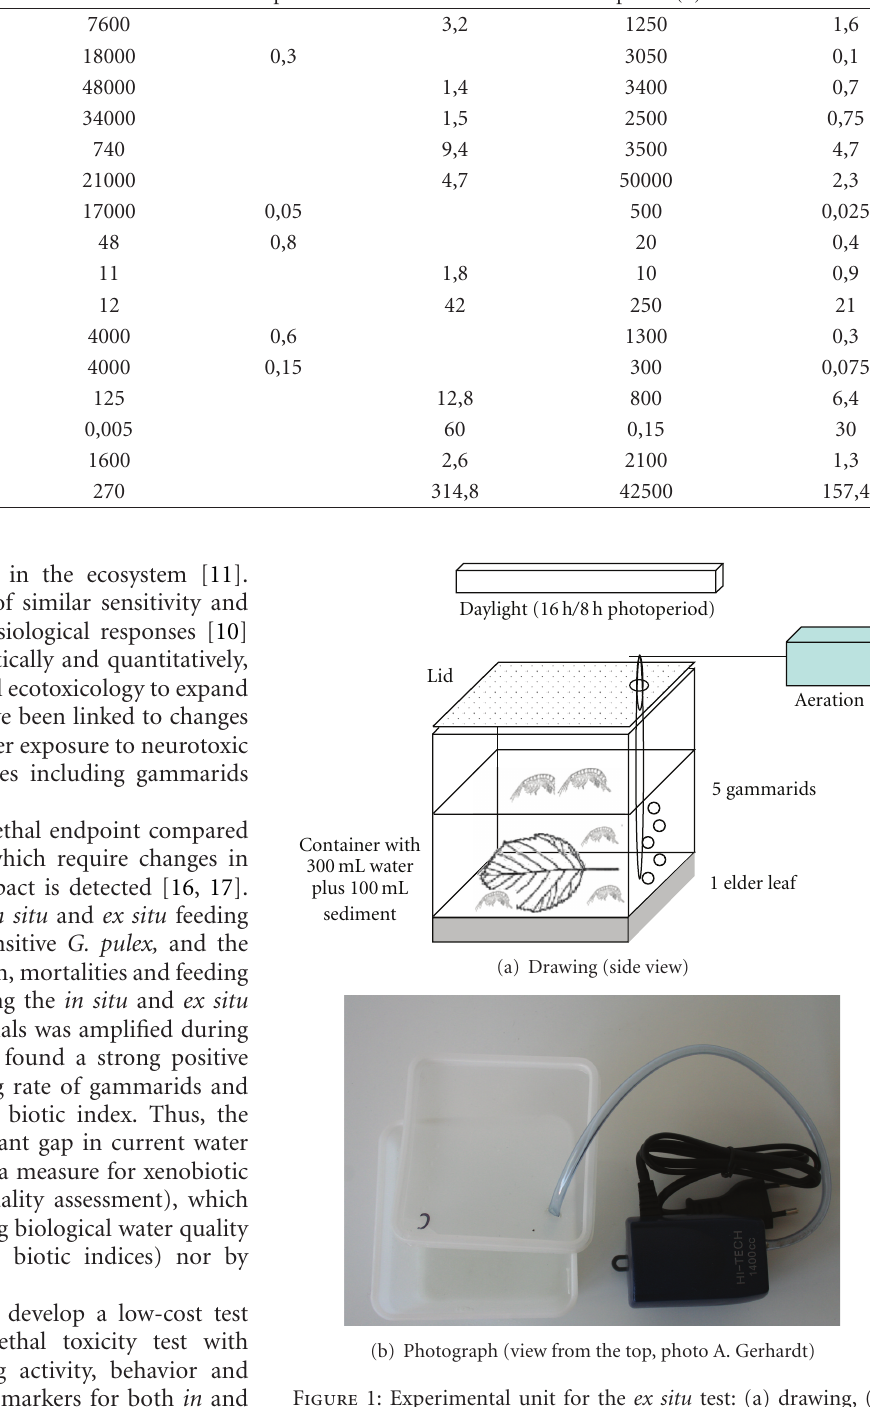
Figure 1: Experimental unit for the ex situ test: (a) drawing, (b)